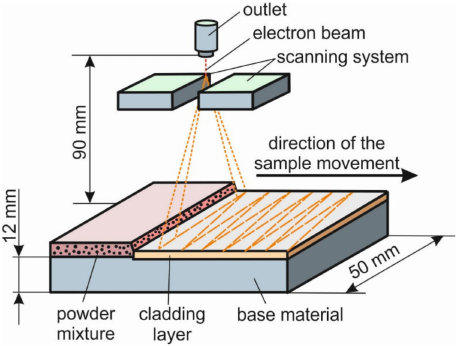
Figure 1. Scheme of the electron beam treatment of a